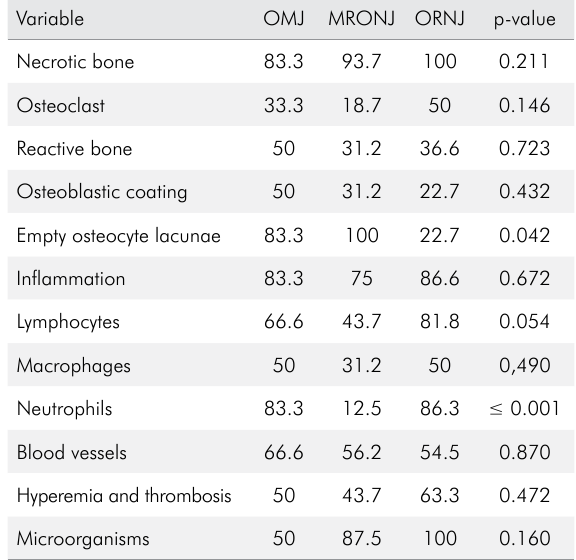
Table 3. Table showing the percentage of all variables compared among the